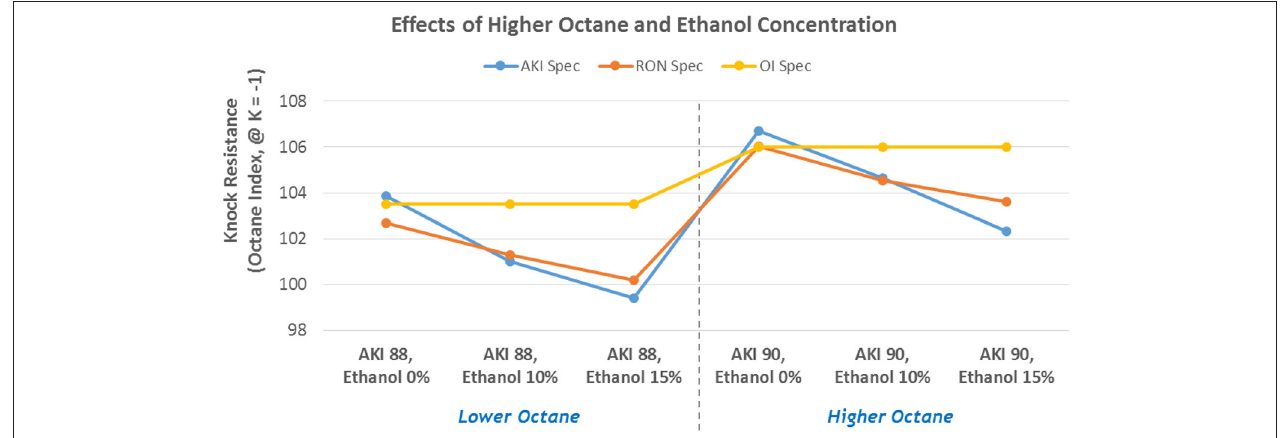
FIGURE 11 | Changes in octane index ( K = − 1) as a results of higher octane production, without and with ethanol up to 15%, under three different specification methods.